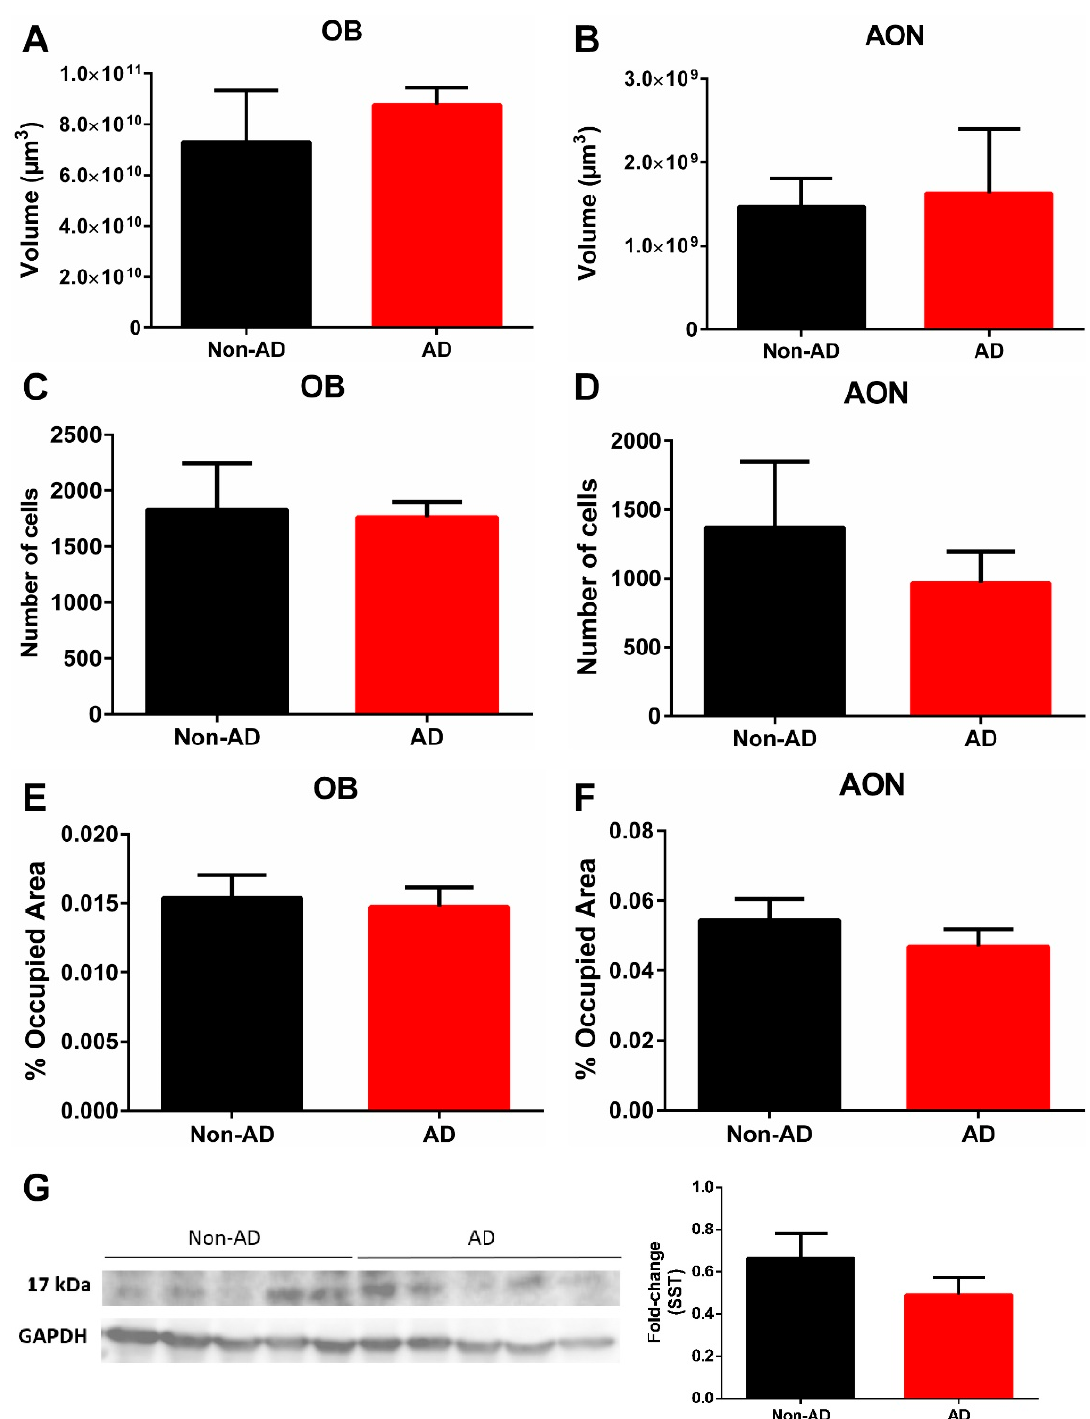
Figure 2. Quantification of volume and somatostatin expression in the olfactory bulb. Neither the olfactory bulb nor the anterior olfactory nucleus showed variation in volume ( A , B ). The results also indicated no difference in either the number of somatostatin-expressing cells ( C , D ) or the area fraction occupied by somatostatin fibers ( E , F ). In addition, Western blot quantifications confirmed no change in somatostatin expression in the olfactory bulb ( G ). For volume, number of cells and somatostatin fibers quantification N = 10 formalin-fixed cases (AD = 5 and non-AD = 5) and 4 sections per case were analyzed. Western blot quantification was performed using N = 20 fresh-frozen cases, AD = 10 and non-AD = 10. See Table 1 and supplementary stereological data for further